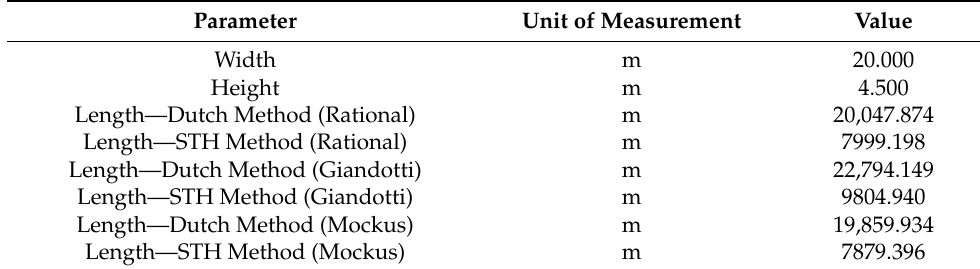
Table 8. Detention basin sizing.